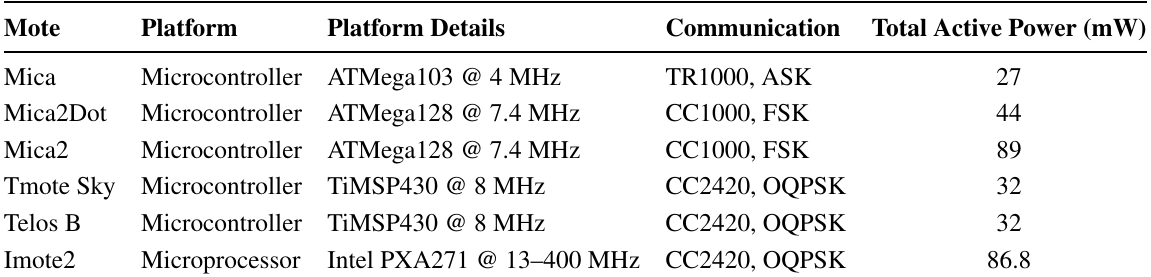
Table 4. Details of commercial sensor